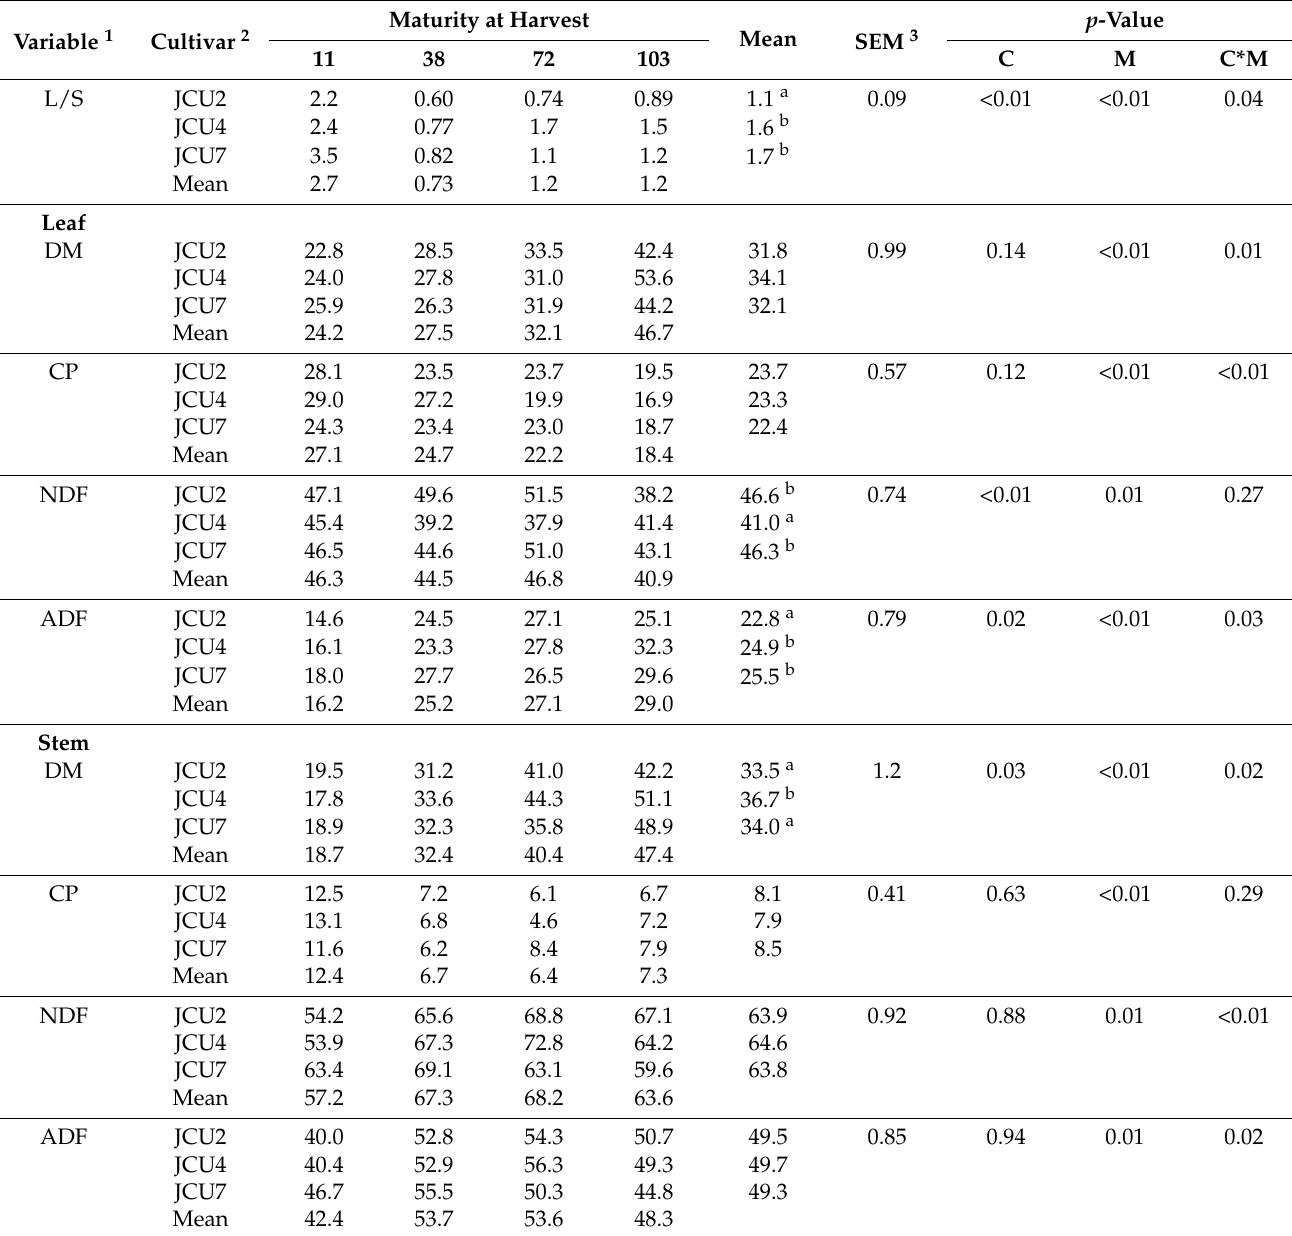
Table 2. Mean leaf to stem mass ratio (L/S), dry matter (DM; %) and chemical composition (% DM) of desmanthus harvested at varying maturity